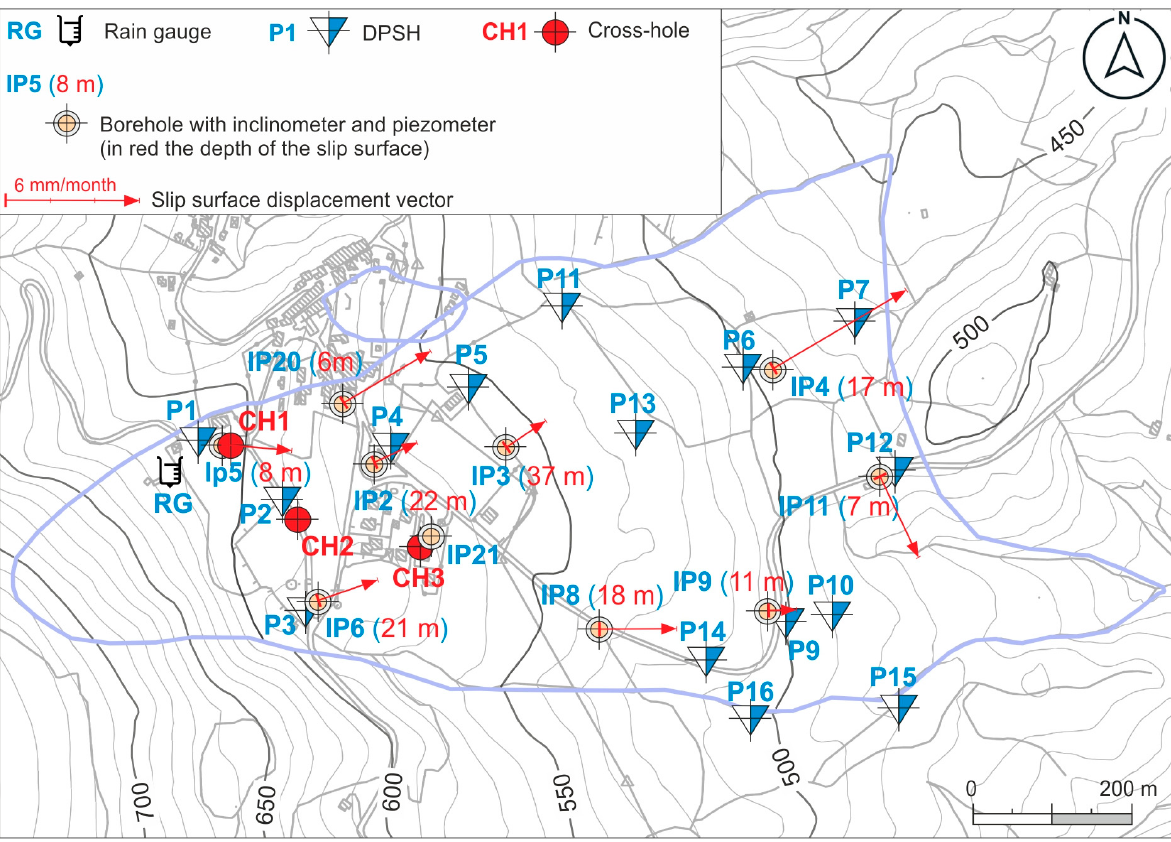
Figure 3. Location of the rain gauge, field investigations, and landslide mass monitoring system (only those falling in the landslide area are reported). Displacement vectors (maximum values during the monitoring period) and the depth of the slip surface were obtained with data collected during the monitoring campaign carried out between February 2003–May 2004, except for IP3, the data of which are referred to 2008.